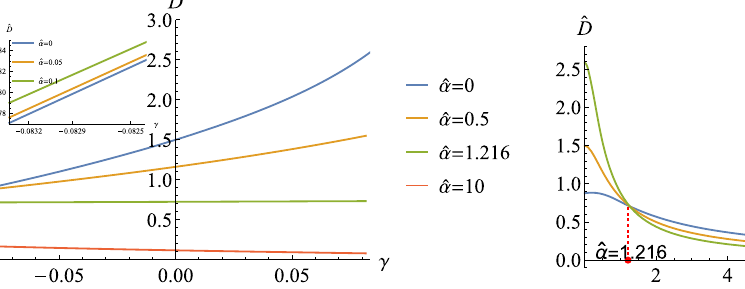
Fig. 7 Left plot: the charge diffusion constant ˆ D versus the Weyl cou- pling parameter γ for some fixed dissipation constant ˆ α . Right plot: the charge diffusion constant ˆ D versus the dissipation constant ˆ α for some